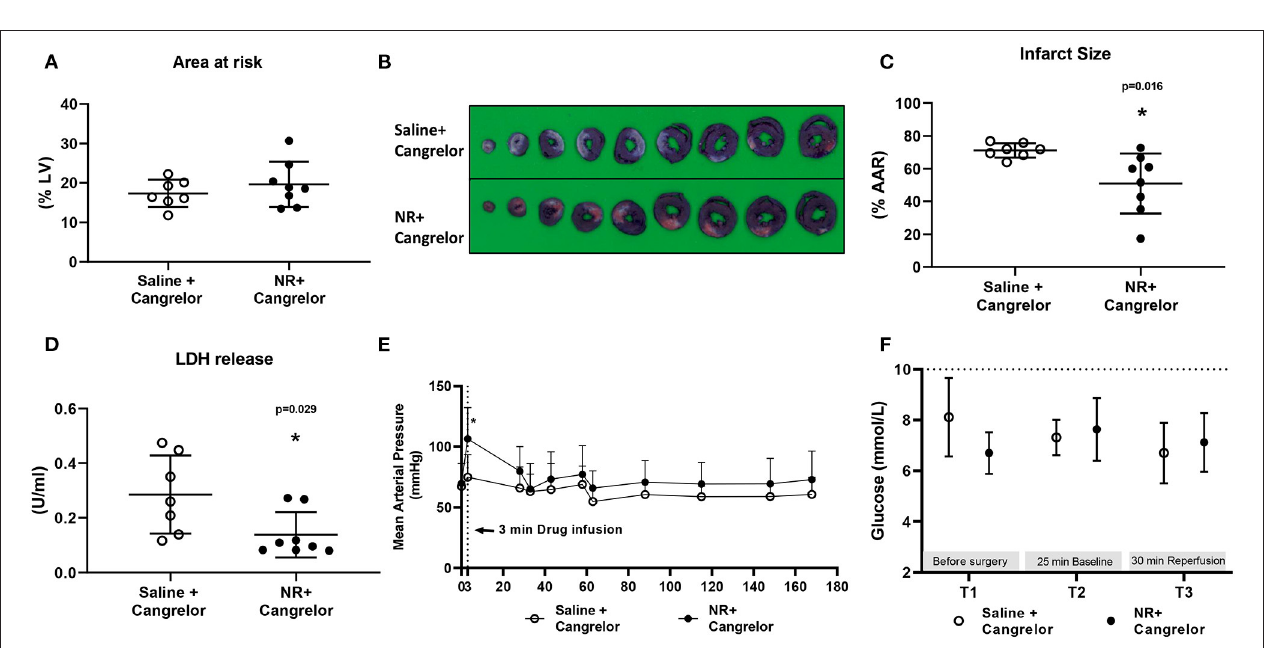
FIGURE 5 | NR effects against in vivo cardiac IR injury in presence of cangrelor. NR treatment reduced infarction in the presence of cangrelor, a common clinically used P2Y12 inhibitor. (A) Area at risk (AAR) related to left ventricle area (LV); (B) Image of TTC staining; (C) Infarct size related to AAR; (D) LDH release; (E) Mean arterial pressure (MAP, mmHg) throughout the whole protocol; (F) glucose level at three time point. * P < 0.05 vs. Saline group, AAR/LV and IS/AAR data was analyzed by Student’s t -test; LDH data was analyzed by Mann-Whitney U test; MAP and glucose level were analyzed using two-way Repeated Measures ANOVA applying the Bonferroni multiple comparisons test when relevant. Saline group ( n = 7); NR group ( n =